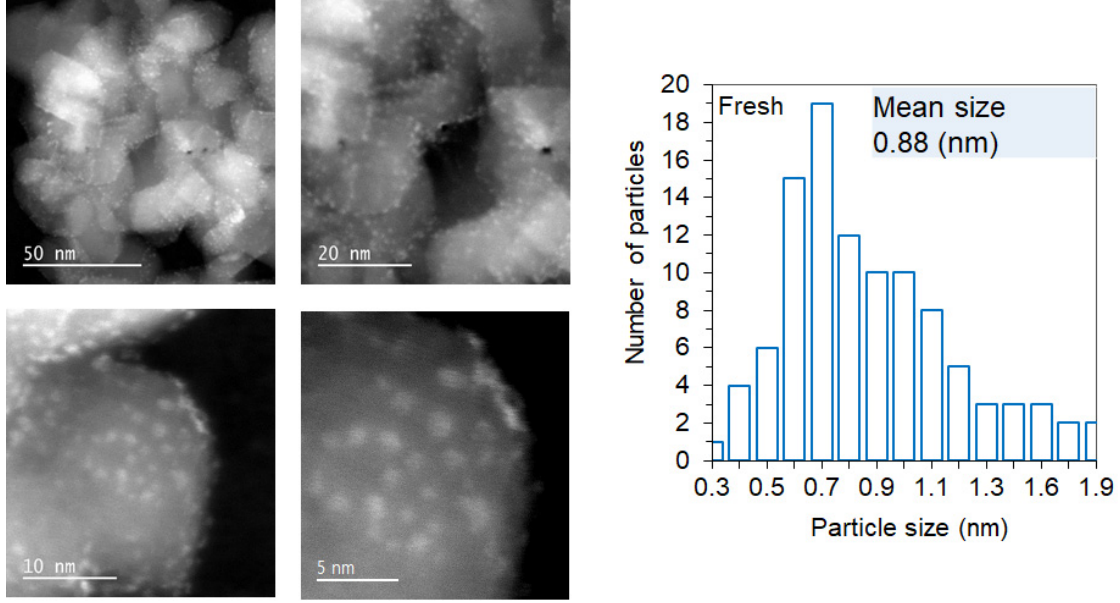
Figure 5. TEM images and extracted mean particle size of as-prepared 3.5 wt.% IrO 2 /TiO 2 (anatase, BET surface area = 55 m 2 /g) at different magnifications. Standard errors (0.03 nm).